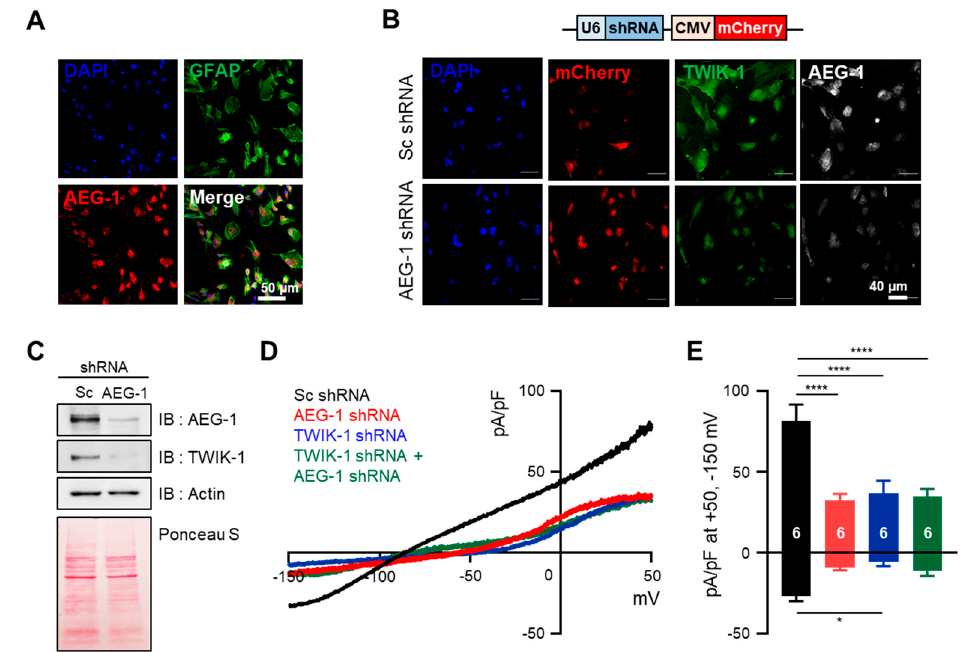
Figure 2. AEG-1 knockdown reduces TWIK-1 protein levels and TWIK-1-mediated potassium currents in primary cultured astrocytes. ( A ) Immunofluorescence staining of cultured astrocytes using AEG-1 and GFAP, an astrocyte marker. ( B ) Immunofluorescence staining of TWIK-1 and AEG-1 in transfected astrocyte. Knockdown of the AEG-1 inhibits the levels of TWIK-1. Scale bar, 40 µ m. The shRNA vector contains a shRNA sequence under the control of U6 promoter, with mCherry co-expression under a CMV promoter. ( C ) Knockdown of the AEG-1 in primary cultured astrocytes. Immunoblot data show the decreased AEG-1 and TWIK-1 expression. ( D ) Representative whole-cell I–V curves of astrocytes overexpressing Sc shRNA (black), AEG-1 shRNA (red), TWIK-1 shRNA (blue), and AEG-1 and TWIK-1 shRNAs (green). ( E ) Pooled data for whole-cell current amplitudes in AEG-1 knockdown, TWIK-1 knockdown, and AEG-1 and TWIK-1 double knockdown astrocytes. All values are presented as mean ± SEM. * p < 0.05, **** p < 0.0001. Two-way ANOVA followed by the Tukey’s post hoc.